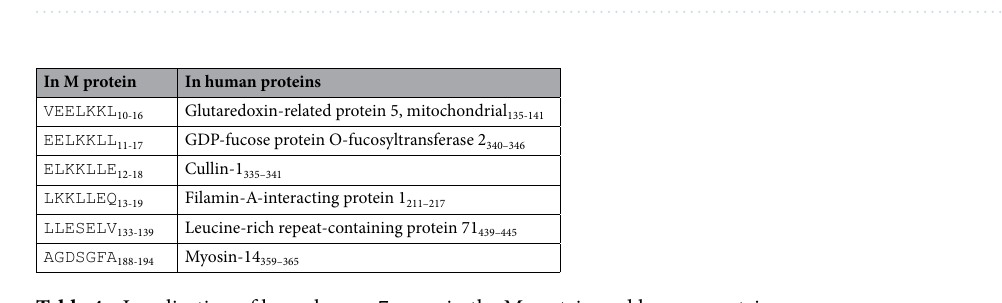
Table 3. Localization of some of homologous 7-/8-mers in the E protein and human gut proteome.